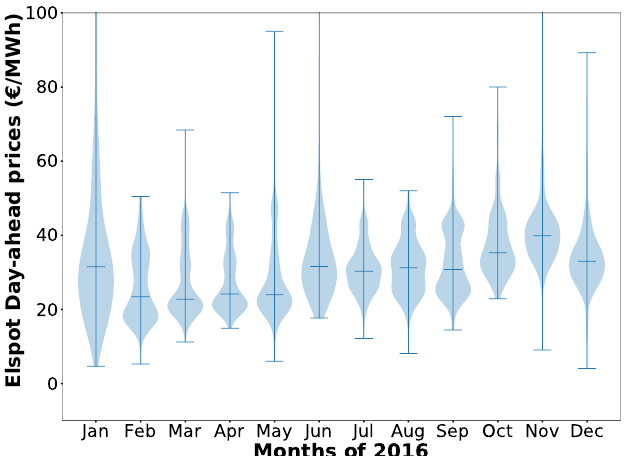
Figure 4. Elspot market price distribution by month for the year 2016, with representation of the median value.